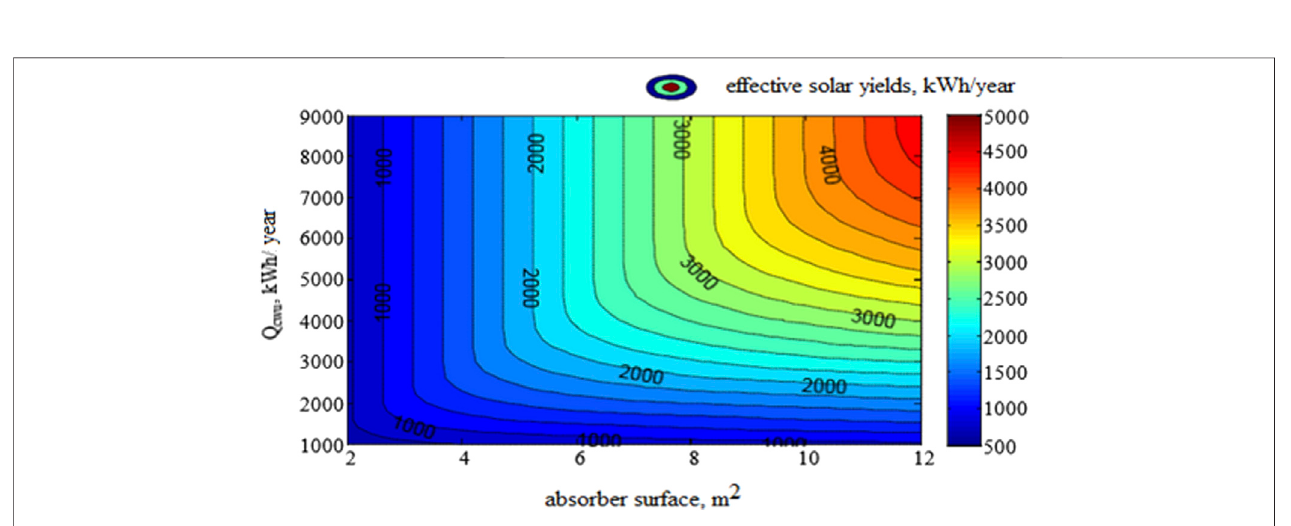
FIGURE 5 | Diagram of examples of effective solar yields as a function of the absorber area and heat demand for hot water preparation. Source: own study.